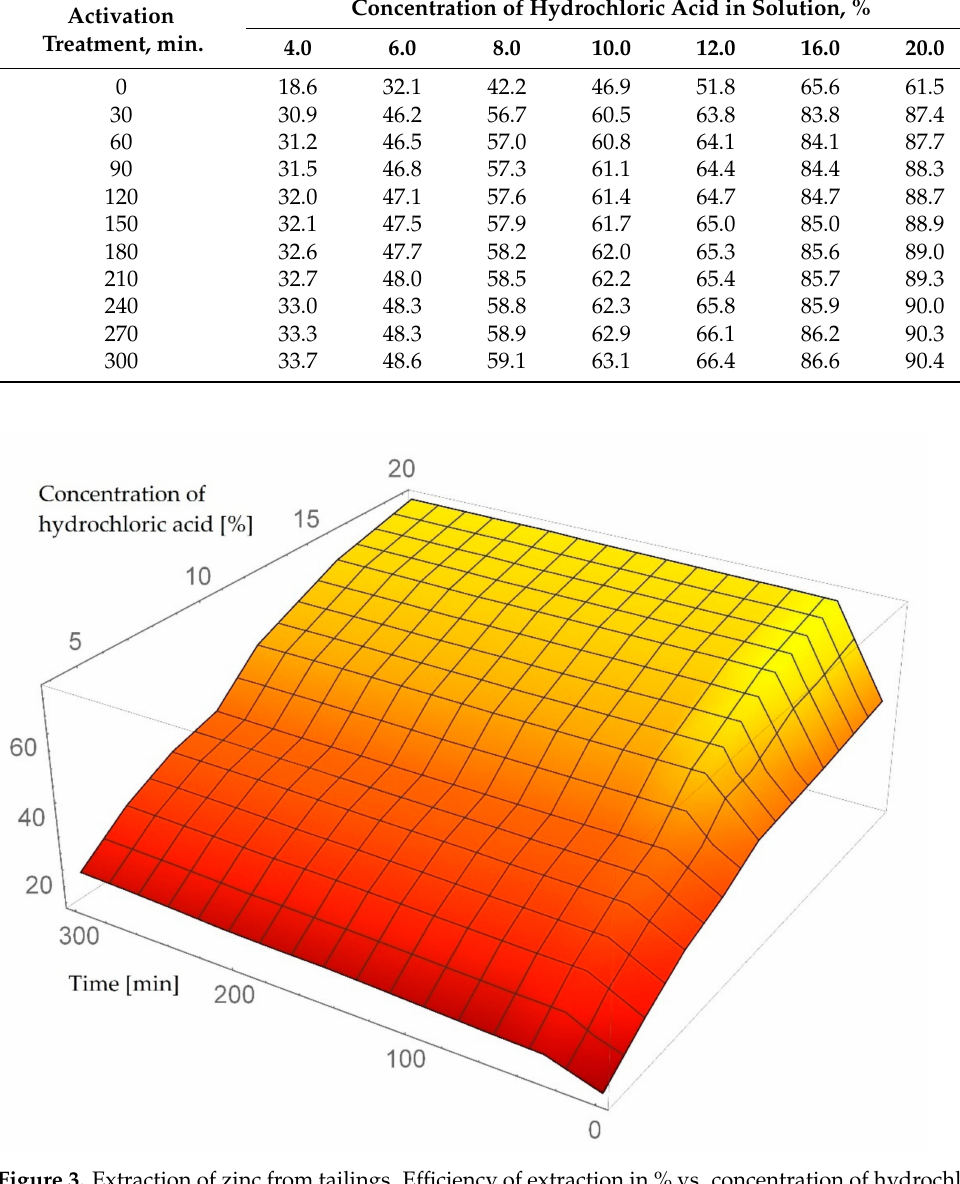
Figure 3. Extraction of zinc from tailings. Efficiency of extraction in % vs. concentration of hydrochlo- ric acid in solution and duration of activation